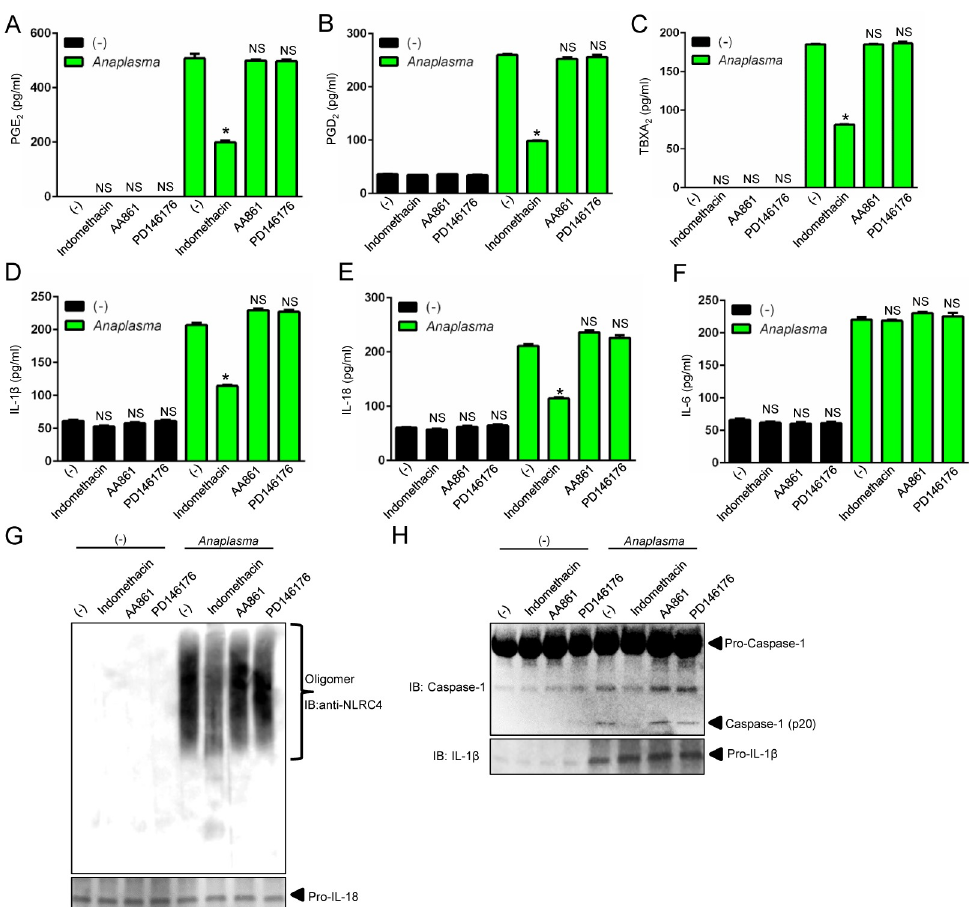
Fig 4. The COX pathway mediates the A . phagocytophilum -induced NLRC4 inflammasome. Wildtype (WT) BMDMs (1 x10 6 cells) were pre-treated with indomethacin (100 nM), AA861 (1 μ g/ml) and PD146176 (1 μ g/ml) for 2 hours followed by A . phagocytophilum infection (MOI50) for 18 hours. The levels of (A) PGE 2 , (B) PGD 2 , (C) TBXA 2, (D) IL-1 β , (E) IL-18 and (F) IL-6 were measured by ELISA in the cell culture supernatants. (G) NLRC4 detection by native gel/immunoblotting (IB) and (H) SDS-PAGE caspase-1 western blot indicating autoproteolysis (p20). Pro-IL-1 β and IL-18 were used as loading controls. One-way ANOVA-Tukey * P < .05; NS, not significant. (-)